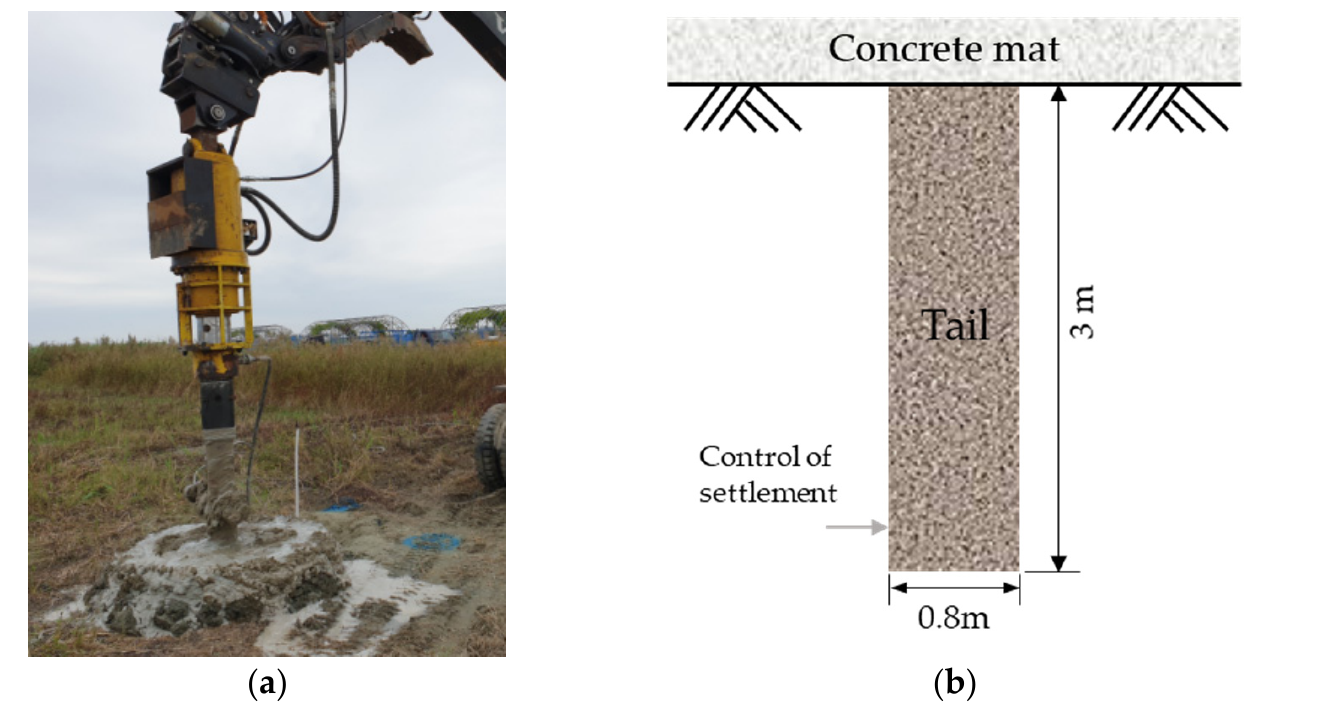
Figure 1. Stirring process and cross-section view of the DCM method. ( a ) Stirring process of the DCM method. ( b ) Layout of the DCM reinforcement method [9] .